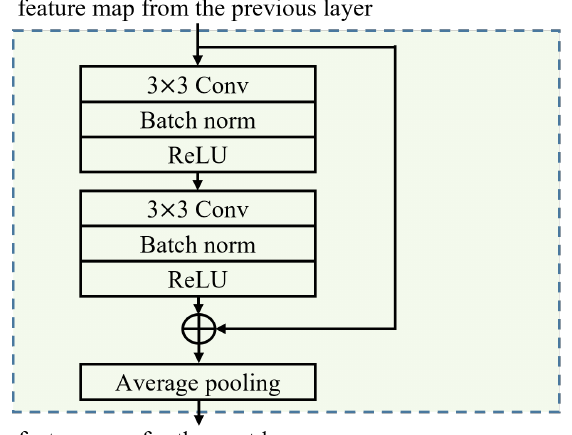
Figure 2. Block diagram of a residual convolutional block comprising a CNN layer with residual connections, batch normalization, and max pooling